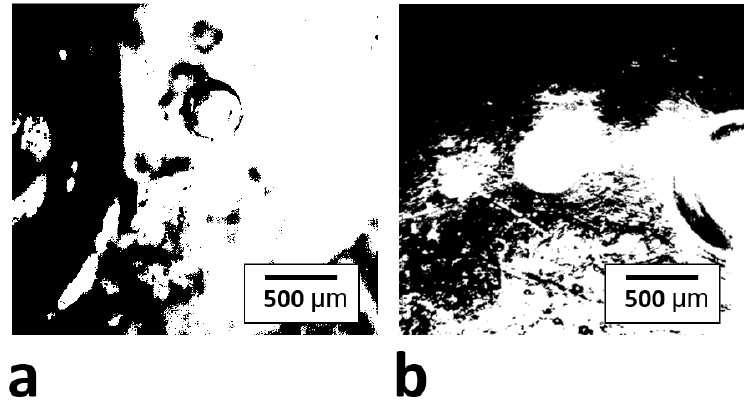
Figure 10. Binarized black and white image of the HT-CSLM microscopy image of ( a ) the silica particle as seen in Figure 6a and ( b ) alumina particles as seen in Figure 7a.